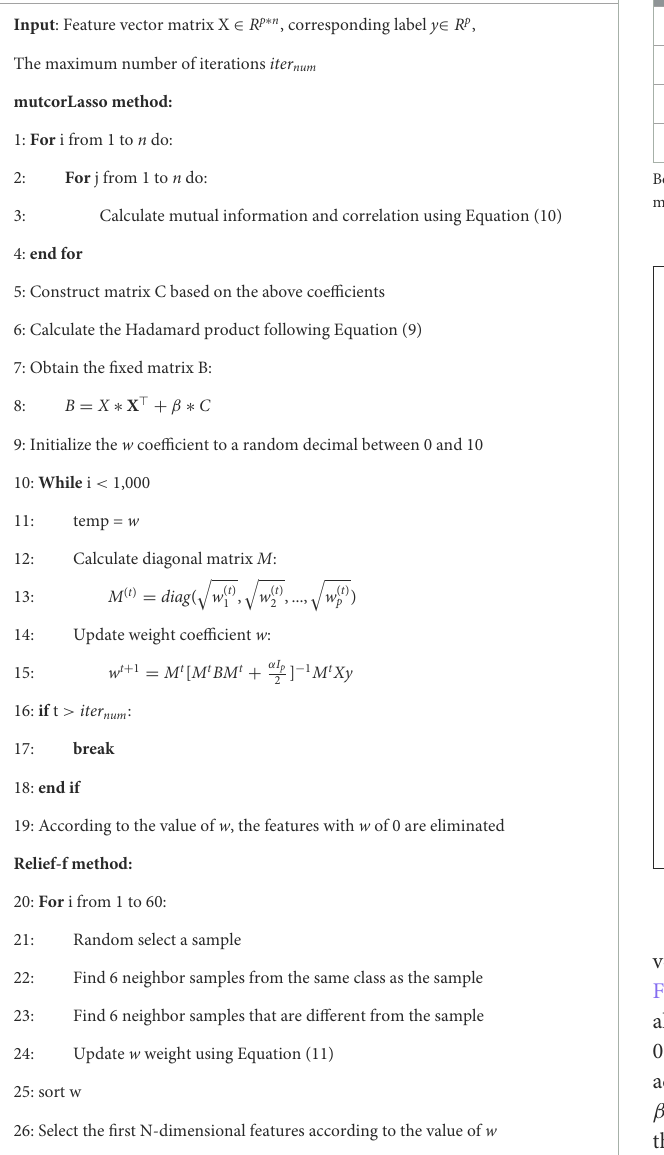
TABLE 1 The pseudo code of the feature selection algorithm. Algorithm: Procedure of mutcorLasso+Relief-f